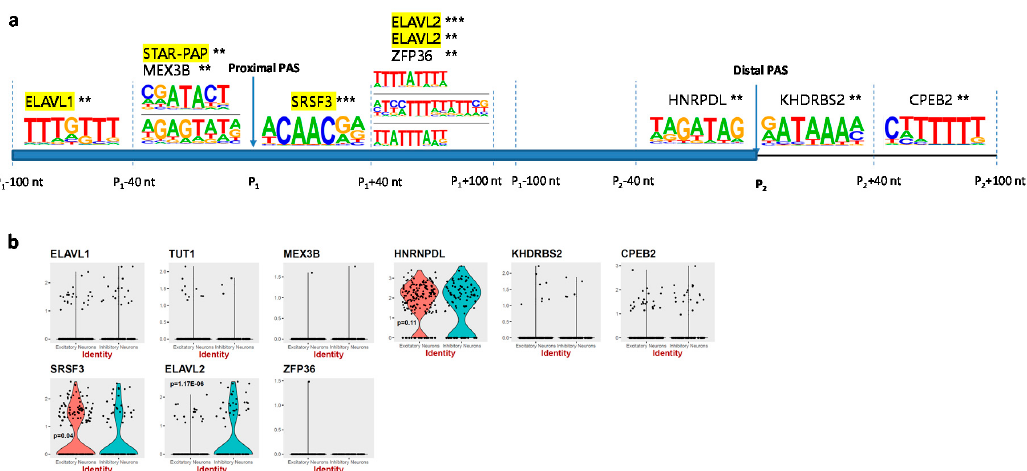
Figure 3. Identification of RNA-binding protein (RBP)-binding motifs around PAS. ( a ) Known RBP-binding motifs based on comparison of edPAS versus idPAS. Yellow colored RBPs were found to be involved in regulating APA (Neve J et al. RNA Biology. 2017; Camron D. Bryant et al. Genes Brain Behav.2016). * represents p -value is less than 0.05; ** represents p -value is less than 0.01; *** indicates p -value is less than 0.001; ( b ) Neuron specific expression of RBPs. Y axis value showing the normalized and natural log-transformed single cell expression. X axis showing the cell types, excitatory neurons colored in red and inhibitory neurons colored in green. p -value indicates evidence of di ff erential expression of RBP between two groups examined using the Wilcoxon Rank Sum